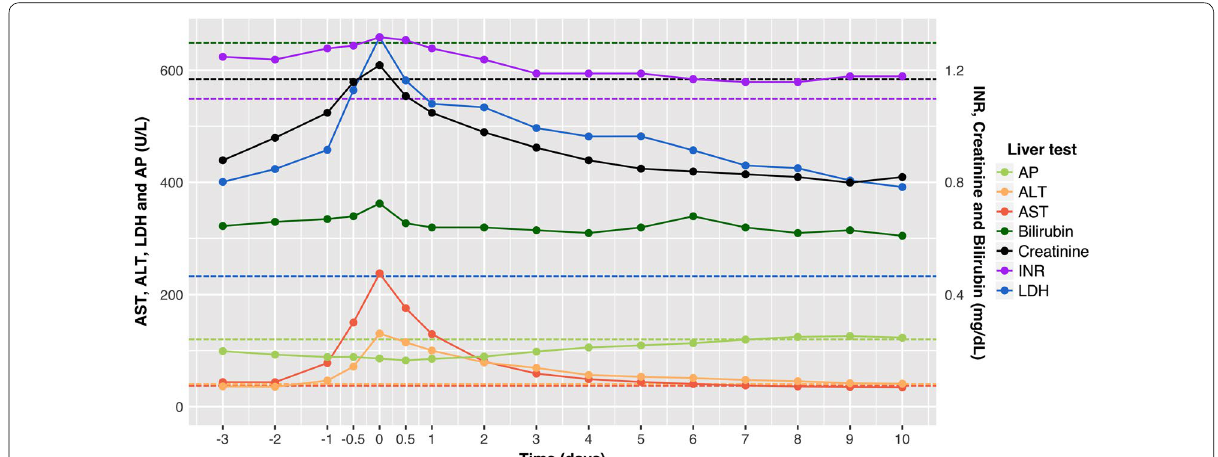
Fig. 6 Time trend of liver tests in hypoxic hepatitis of the ASTmax subgroup 10-20x ULN. Time trend of the median AP, ALT, AST, bilirubin, creatinine, INR and LDH levels in hypoxic hepatitis. T-ASTmax is designated as time 0. AST, ALT, LDH and AP levels are measured in U/L and are plotted using the left y-axis. Bilirubin and creatinine levels are measured in mg/dL and plotted using the right y-axis. INR has no unit, but is also plotted using the right y-axis. AP alkaline phosphatase, ALT alanine aminotransferase, AST aspartate aminotransferase, INR international normalized ratio, LDH lactate dehydrogenase